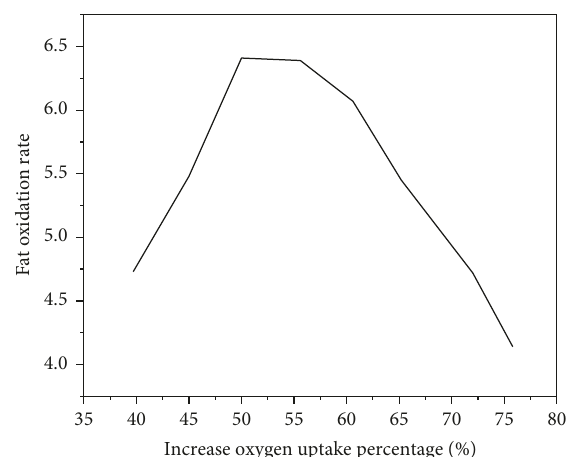
Figure 2: Change curve of the fat oxidation rate of male and female college